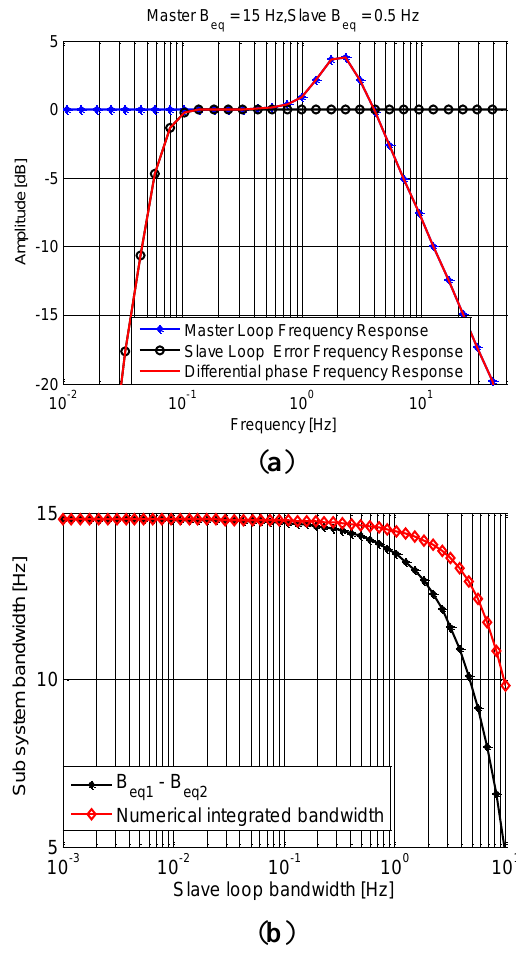
Figure 4. Frequency responses and the bandwidth of the sub system. ( a ) Frequency responses of H 1 ( s ), H e2 ( s ) and H d ( s ); ( b ) Bandwidth of the sub